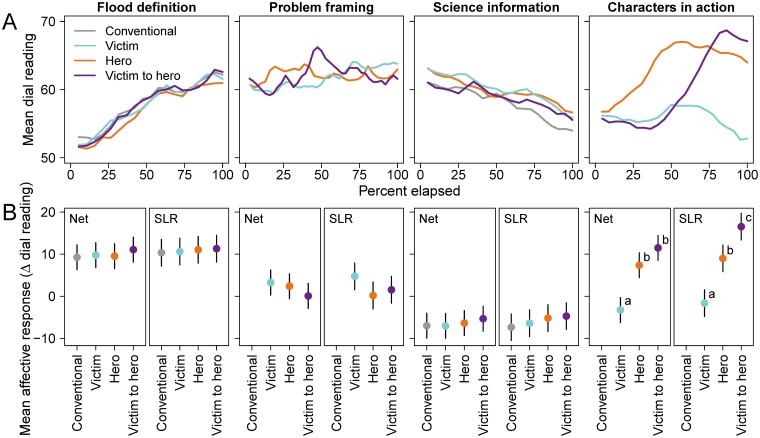
Transportation by dial readings with TNet and TSLR.(A) Mean dial readings of participants for each science message by segment. (B) Estimates of mean change in dial readings and 95% confidence intervals by segment. Negative affective responses fall below zero and positive affective responses above zero. The calculation of transportation is indicated by Net for TNet and SLR for TSLR as described in Methods: Data and measures of transportation. Point estimates and 95% confidence intervals were generated from marginal means of the linear mixed-effects models as described in Methods: Statistical analyses. Letters adjacent to point estimates denote statistically significant differences.